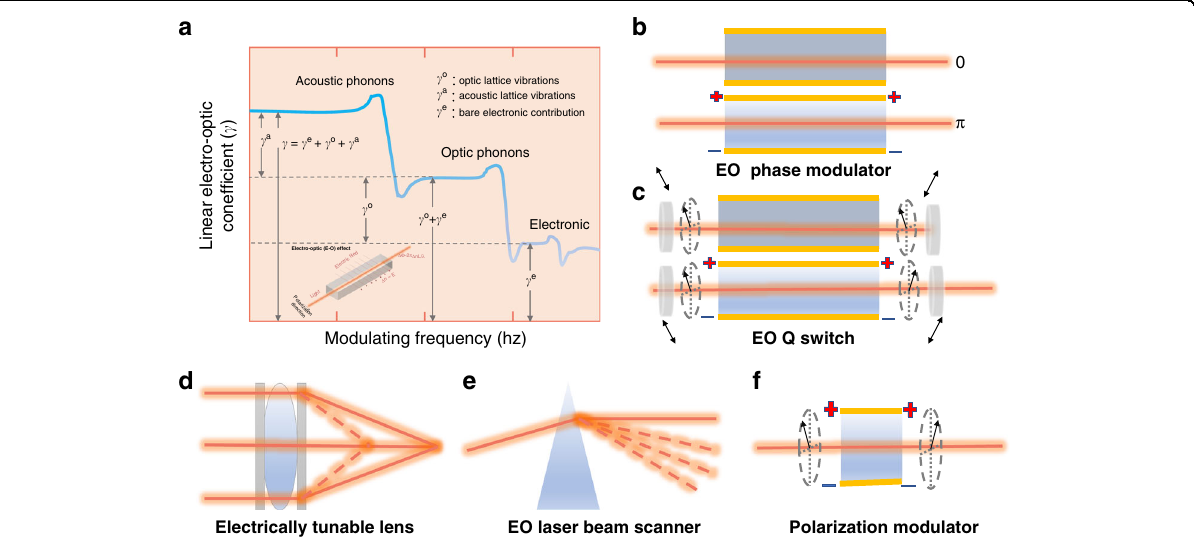
Fig. 1 Electro-optic effect and some application. a Three contributions of Electro-optic (EO) coef fi cients: acoustic phonons, optic phonons, and electronic. b – f EO effect devices: b high-speed EO phase modulator, where an electric fi eld changes the phase delay of a laser beam sent through the crystal; c EO Q-switch are modulators where the transmission is either switched on or off, rather than varied gradually. d Electrically tunable lenses, comparing to the traditional solid lenses with fi xed refractive index, the refractive index of lenses is electrically tunable. Therefore, the focal length of lens is tunable by properly controlled the optical phase as aspheric or Fresnel lens phase pro fi le. e EO laser beam scanner refract light by applying a phase delay by changing the refractive index of the medium, and by adjusting the voltage applied to the crystal to change the steering angle to EO control the phase delay across the beam cross-section. f Polarization modulator can thus be seen as a voltage-controlled waveplate, and it can be used for modulating the polarization state